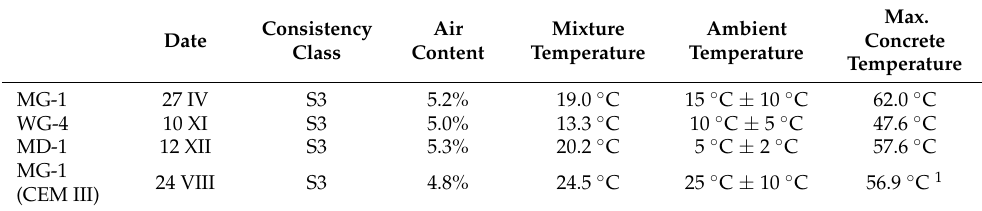
Table 2. Temperatures in reference blocks.